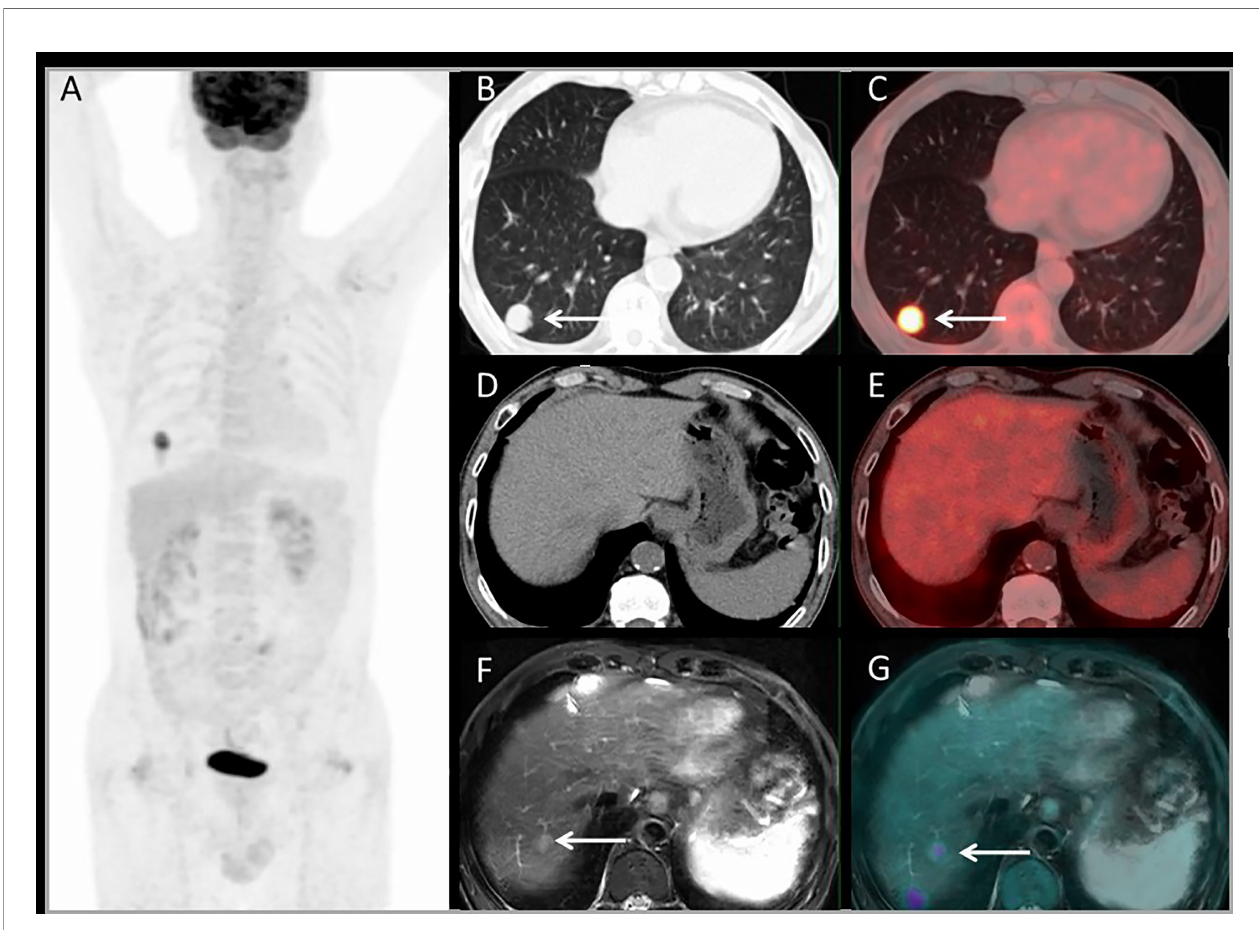
FIGURE 4 | Images of a 63-year-old male with colonic liver metastasis. The MIP (A) of PET/CT showed a lesion on right lung but no 18 F-FDG foci on liver. CT and PET/CT fusion images showed single lung metastasis with high 18 F-FDG uptake (B, C) and no lesions were detected on liver (D, E) . T2WI and PET/MRI fusion images showed a single lesion on right liver lobe with mild 18 F-FDG uptake (F, G)